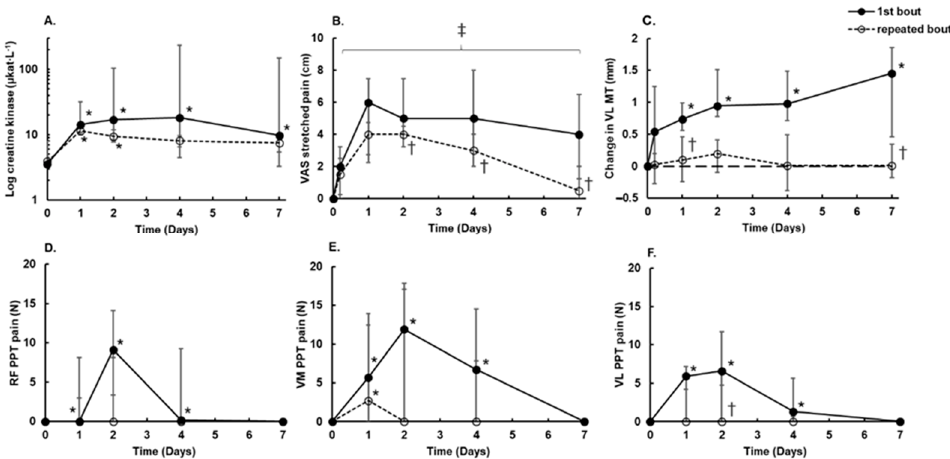
Figure 1. Responses to a repeated bout of 200 knee extension eccentric contractions. ( A ) Plasma creatine kinase (CK) activity expressed on a log scale. ( B ) Visual analog scale (VAS) to rate stretched muscle pain. ( C ) Thickness of vastus lateralis (VL). ( D ) Pressure pain threshold (PPT) in rectus femoris (RF). ( E ) PPT pain in vastus medialis (VM). ( F ) PPT pain in VL. Data are presented as the median and interquartile range (IQR) ( n = 11). Filled circles and solid lines are data for the first bout; open circles and dashed lines are data for the repeated bout. * Significant difference from before exercise ( p < 0.05). ‡ Significant difference from before exercise for both exercise bouts ( p < 0.05). † Significant difference from the first exercise bout ( p <